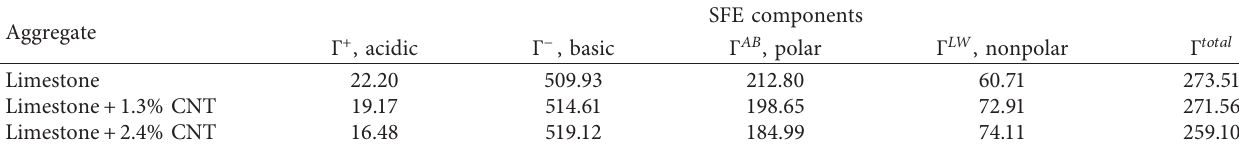
Table 4: : The SFE components of the unmodified and modified aggregates (mJ/m 2 ).